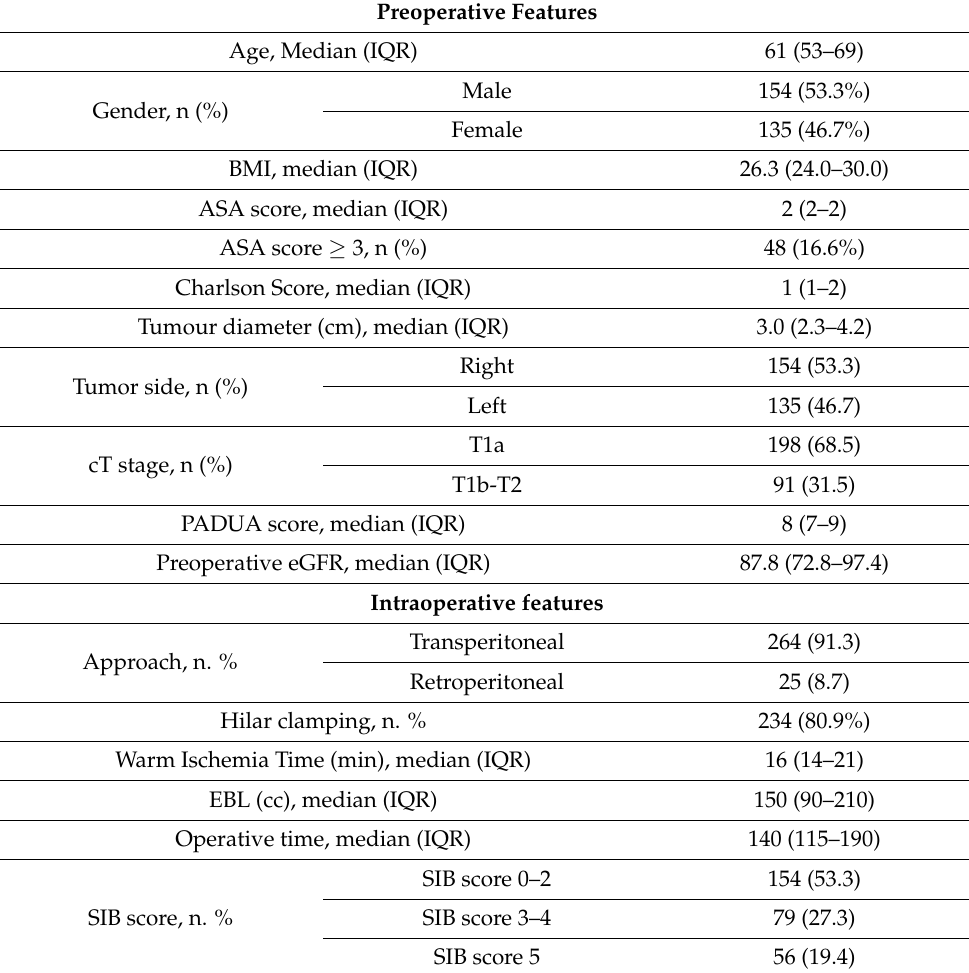
Table 1. Preoperative and intraoperative features of 289 patients treated robotic PN for cT1-T2N0M0 renal tumors.